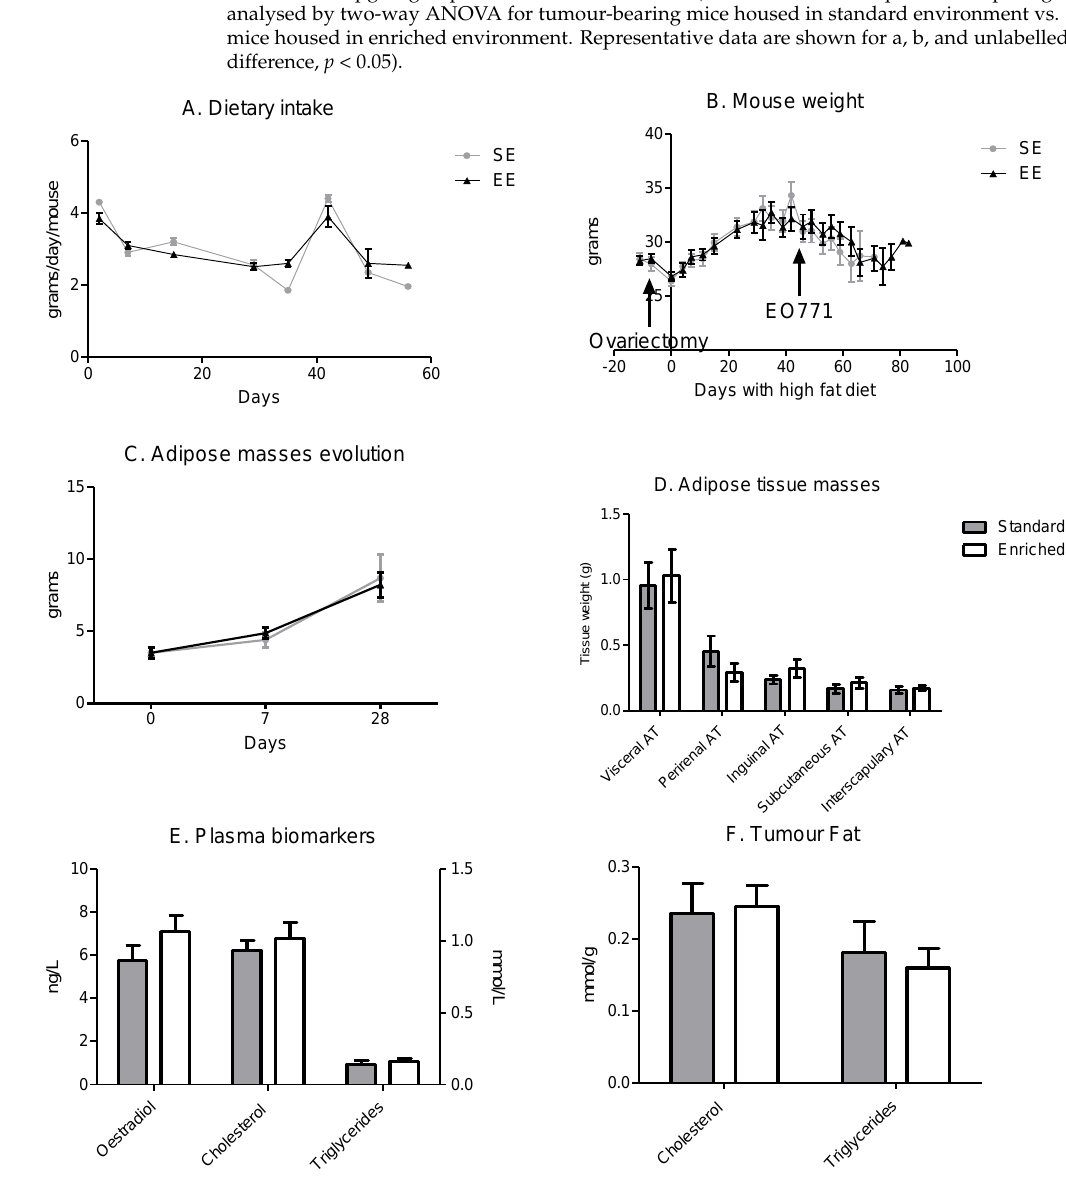
Figure 3. Dietary intakes are equivalent, and the high-fat diet induces an adipose mass gain. ( A ) Dietary intake per day per mouse, results are in grams per day per mouse. (means of 10 mice/group/days) ( B ) Mouse weight during experimentation. Day 0 corresponds to the beginning of the high-fat diet. The surgeries are indicated by an arrow on the graph. Results are in grams. (means of 10 mice/group/days) ( C ) Time course of adipose masses per mouse analysed by EchoMRI. (means of 10 mice/group/days) ( D ) adipose tissue masses at sacrifice in grams (means of 10 mice/group) ( E ) Quantity of oestradiol, cholesterol and triglycerides. ( n = 5 mice plasma samples/group) ( F ) Quantity of cholesterol and triglycerides. ( n = 5 mice tumour samples/group). Data are mean ± SEM. Data were analysed by ANOVA repeated measures.